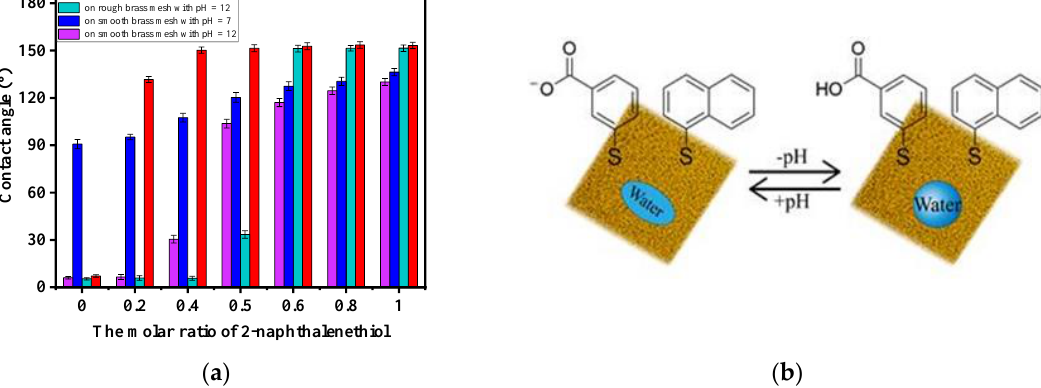
Figure 2. Dependence of the contact angles on X NPT ( a ), the mechanism of pH-responsive property ( b